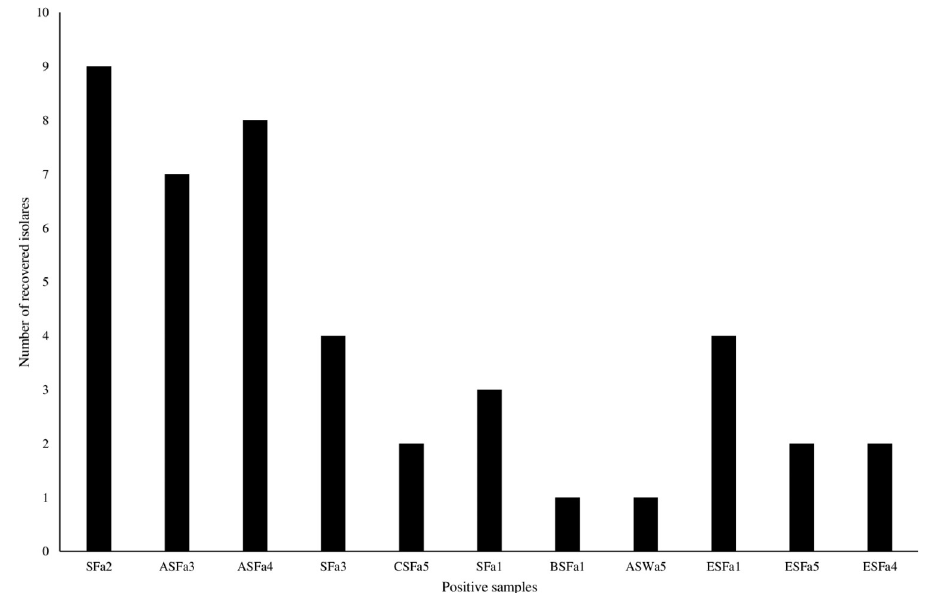
Fig 2. Frequency of Salmonella isolated from positive samples.